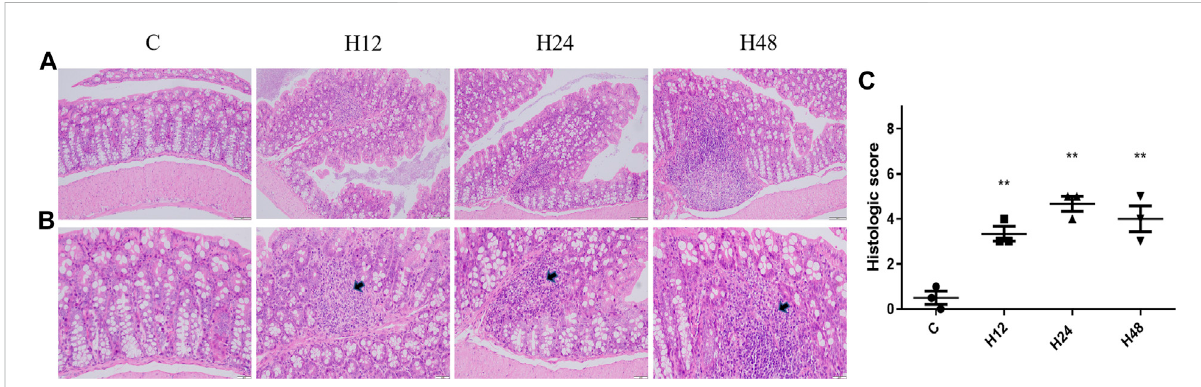
FIGURE 1 Changes in colonic barrier functions in mice from each group. (A) HE staining of colon tissue from mice in each group (×20). (B) HE staining of colon tissue from mice in each group (×40). (C) HE pathological scoring results. C, control group; H12 group, the high-altitude group for 12 h; H24 group, the high-altitude group for 24 h; H48, the high-altitude group for 48 h, n = 3. The data are presented as mean ± standard error of the mean. * p < 0.05 vs . N group, ** p < 0.01 vs . C